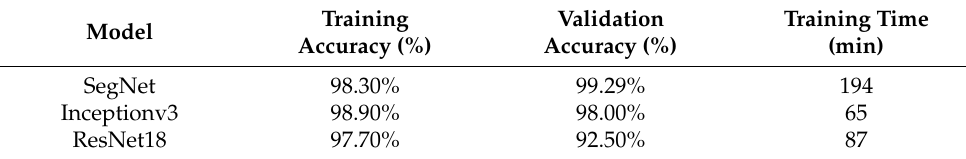
Table 4. The Training results of the SegNet, Inceptionv3, and ResNet18 models. Model